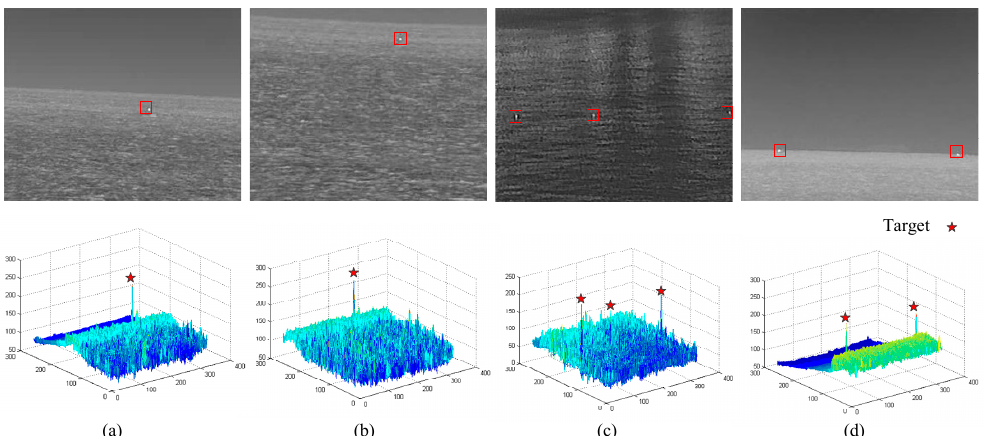
Figure 5. Infrared maritime images including small dim targets: The upper parts of ( a – d ) are the original images and the lower parts are the gray distribution maps of each image.